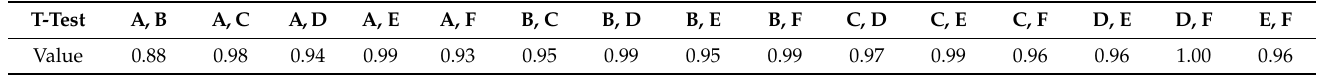
Table A4. T-test results of compressive strength test.